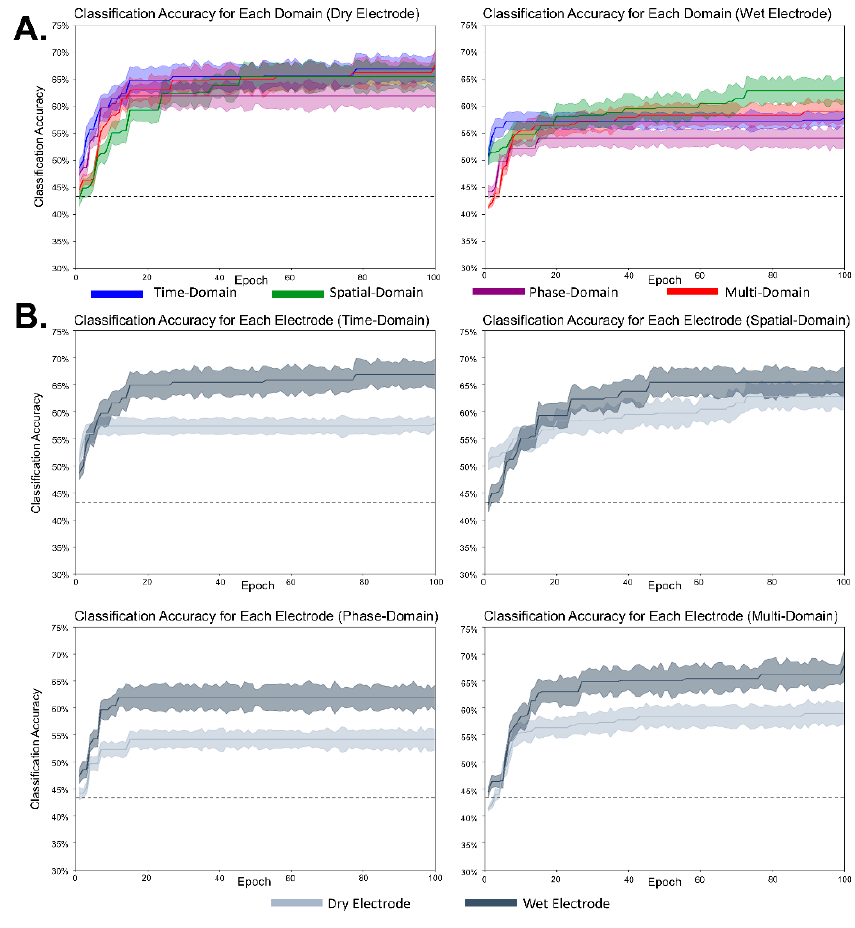
Figure 6. Classification accuracy of the MD-CNN model for S10. The shading represents the standard deviation according to cross-validation. The horizontal dotted line indicates the chance level. ( A ) Classification accuracy for each domain per electrode: time-domain (blue), spatial-domain (green), phase-domain (purple), and multi-domain representation (red). ( B ) Classification accuracy for each electrode per domain: dry electrode (light blue) and wet electrode (dark blue).